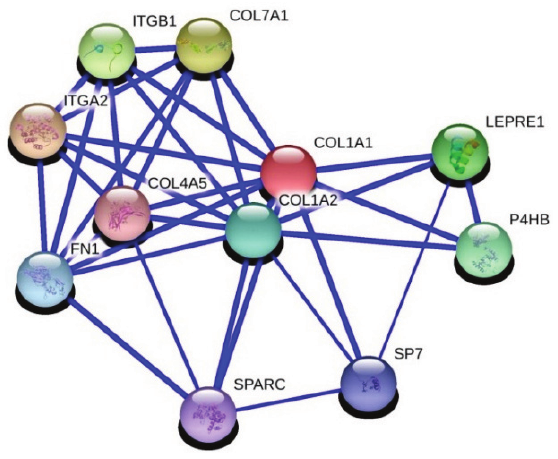
Figure 2. Evidence views of COL1A1 gene and its association with FN1 by using STRING 10.